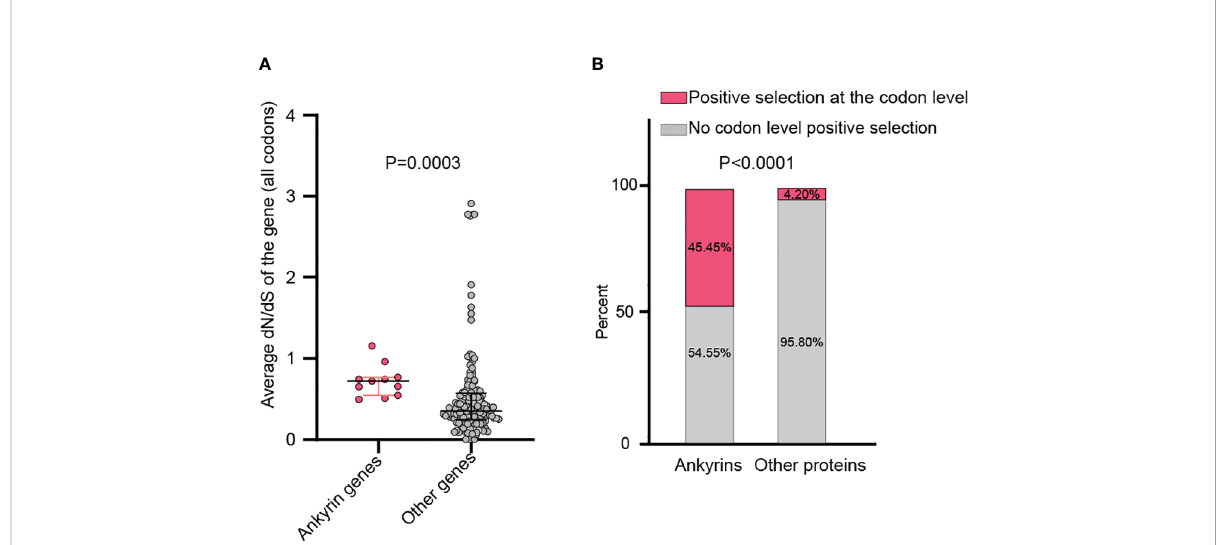
FIGURE 3 Whole gene and the codon-level positive selection on the ankyrin genes of MPXV. (A) Average dN/dS between all the 11 MPXV ankyrin genes and other MPXV genes. Data are shown as dots with 25th, 50th, and 75th percentile lines. The Mann – Whitney U test was used for statistical analysis. (B) Percentage of ankyrin genes, or other types of genes under positive selection. Chi-square test was used for statistical